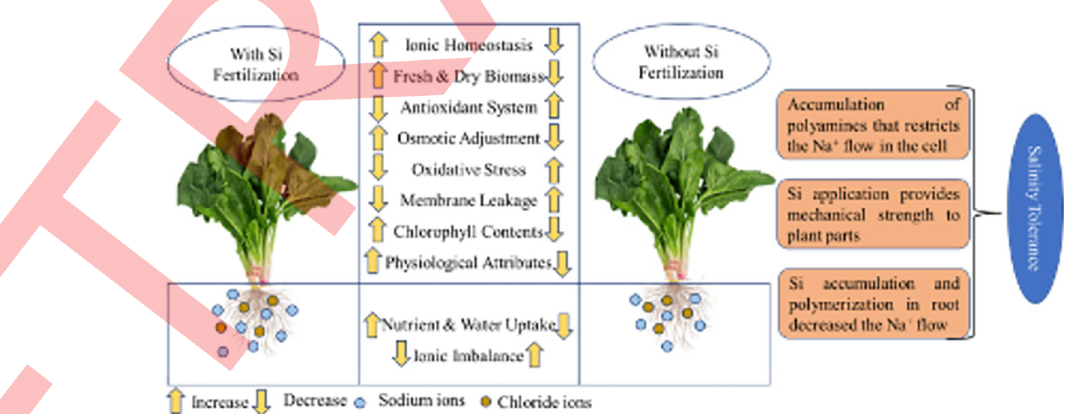
Fig 8. Schematic mechanism of damages caused by salt stress in spinach plants and the protective role of Si fertilization to counteract these damages. The presence of a high concentration of salt in the growing medium causes oxidative, osmotic, and ionic stresses to plants. Increasing the sodium ions in soil lowers the soil water potential of plant cells. This reduces water uptake by plants and consequently results in cellular dehydration, biomass reduction ionic imbalance and lipid peroxidation. To combat this issue, plants induce antioxidative pathways. These antioxidants result in lowering of cellular water potential, membrane leakage and maintain a favorable gradient for water uptake from soil to roots. Si alleviate osmotic stress by influencing the restriction of Na + /Cl − uptake via root, improving of the photosynthetic process, maintenance of redox homeostasis, and effective management of essential elements. Si fertilization reinforces the tolerance mechanism of plants to salinity induced oxidative